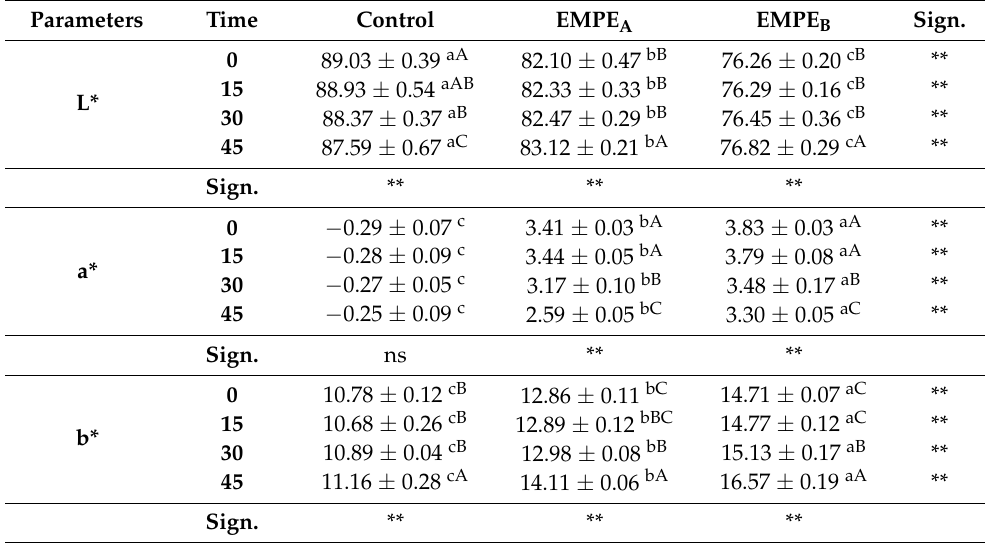
Table 2. Colour parameters of mayonnaise during storage period (days).